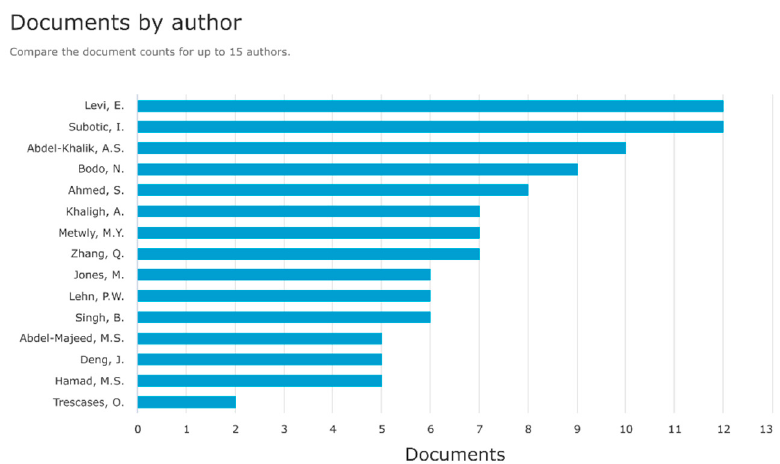
Figure 39. Publication status of top 15 authors on iOBC for electric vehicles from 2010 to until 2022.